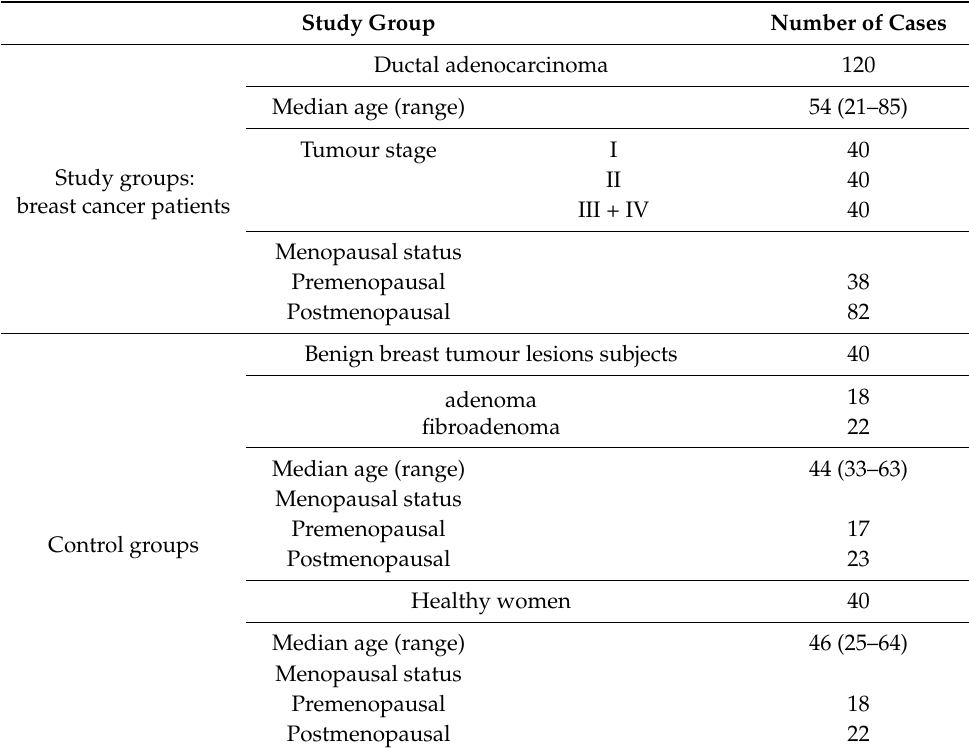
Table 1. Characteristics of examined groups: breast cancer (BC) patients and control groups. Study